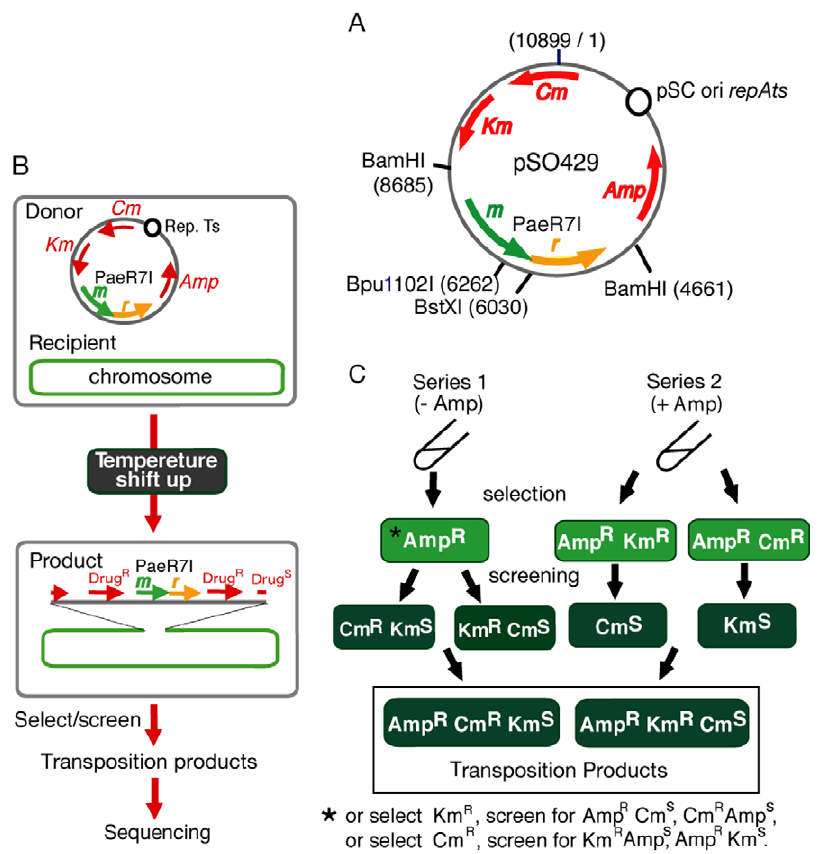
Figure 2. Experimental design for detection of RM gene complex movement. A. The donor plasmid pSO429, which relies on temperature- sensitive (pSC101-derived) replication machinery, carries the PaeR7I RM gene complex and three drug-resistance genes (Amp r , Km r and Cm r ). B. The plasmid was introduced into E. coli . MG1655 strain. The shift to the temperature non-permissive for replication induce cell death due to post- segregational killing, and would allow growth of the cells carrying the plasmid harboring PaeR7I RM genes. C. In the absence of ampicillin (series 1) or in its presence (series 2), cells retaining at least one drug-resistance gene (Amp r or Km r ) and missing one (series 1), or cells retaining two drug- resistance genes (Amp r and Kan r , or Amp r and Cm r ) and missing one (series 2) were selected and screened at 42 u C on solid medium. The double drug-resistant clones (three types in series 1 and two types in series 2) obtained from the above process were subjected to sequencing to determine the integration point on the chromosome.